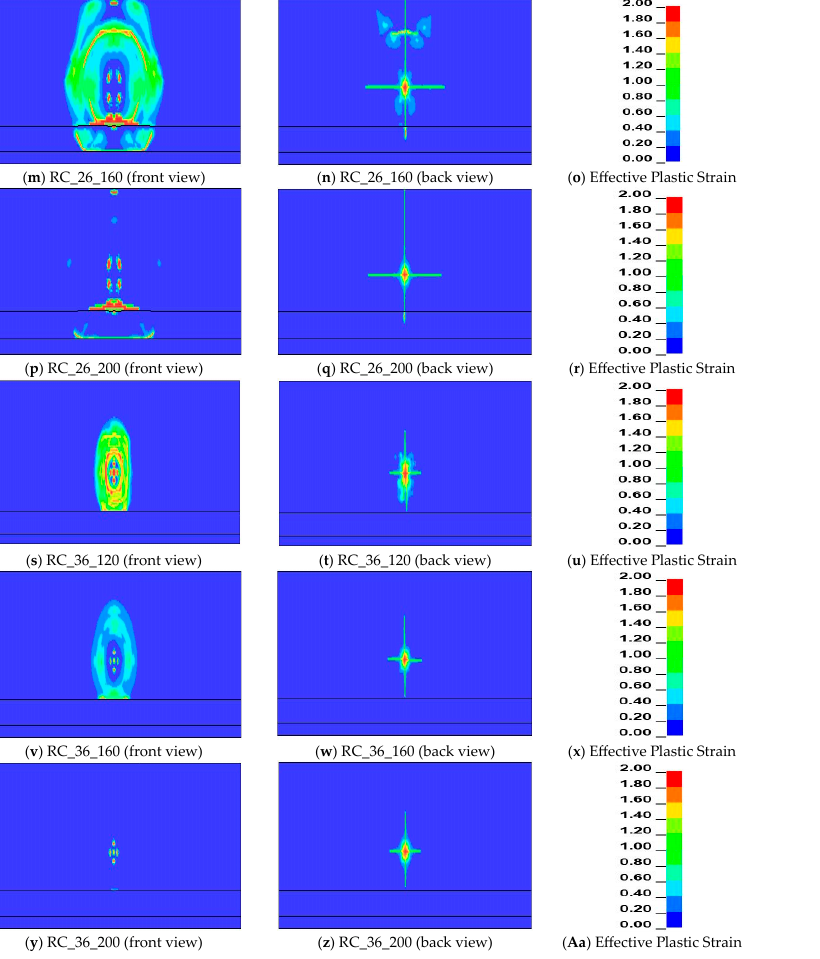
Figure 12. E ff ective plastic strain on reinforced concrete with di ff erent thickness and stand-o ff dis- tance during 30 kg of Hydrogen Gas Explosion. Figure 12. Effective plastic strain on reinforced concrete with different thickness and stand-off distance during 30 kg of Hydrogen Gas